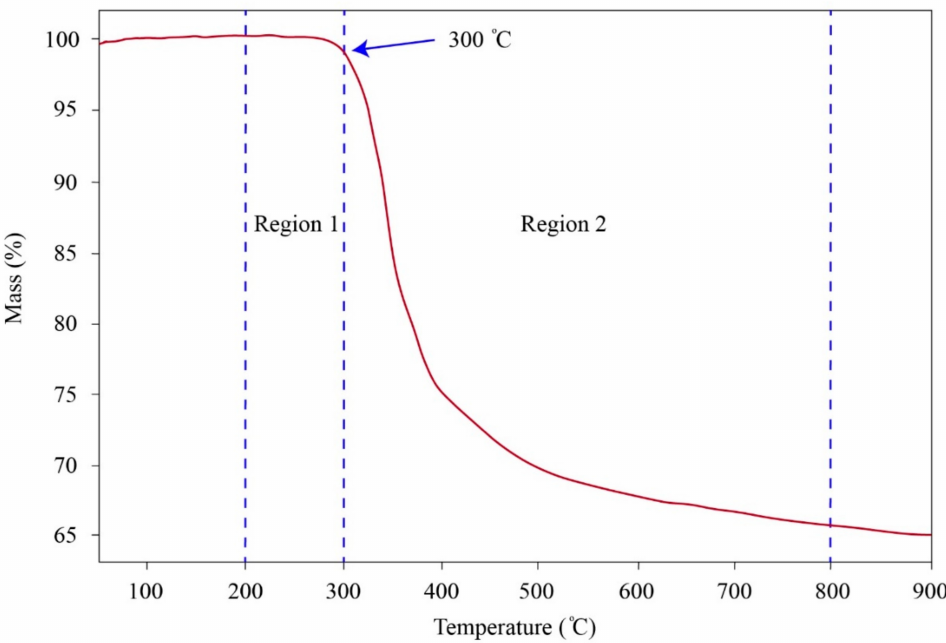
Figure 3. Thermo-gravimetric analysis (TGA) curve of WPCBs for thermal shock (Region 1, [14]) and pyrolysis (Region 2, [57]). Thermal shock temperatures and pyrolysis onset temperatures often differ in different studies. Reproduced from [58] with permission from Waste